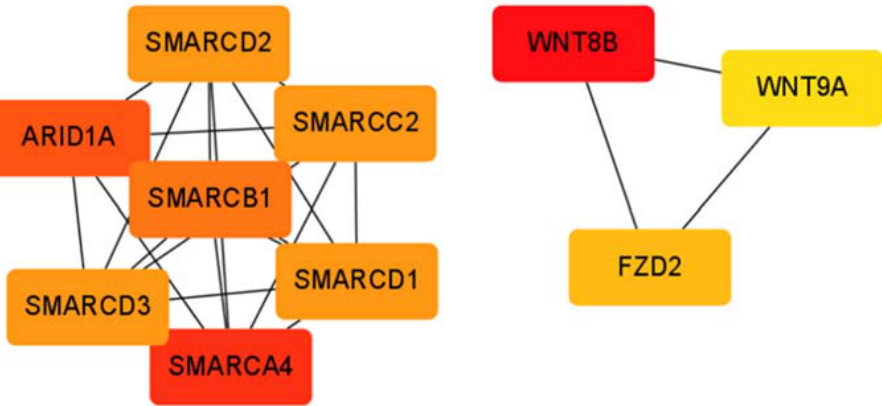
Figure 6. Ten upregulated hub genes in the HCCW4 subclass. The shade of the color indicates the degree of importance of the genes. The sequence of colors is red–orange–yellow from most importance to less importance.